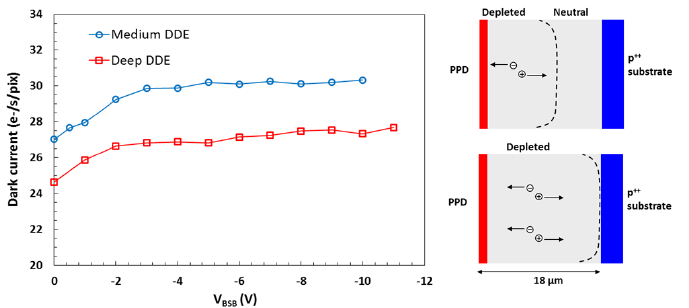
Figure 14. Dark current measurements in two FSI 10 µm pixels and a diagram illustrating the principle of the measurement.